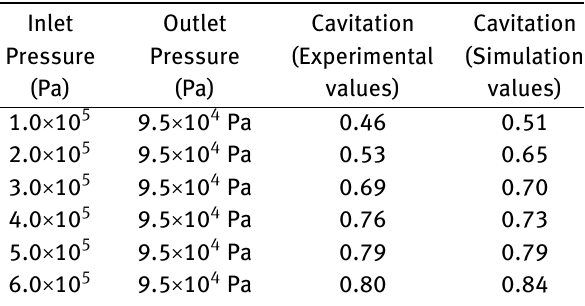
Table 2: Boundary conditions & comparison of Cavitation values